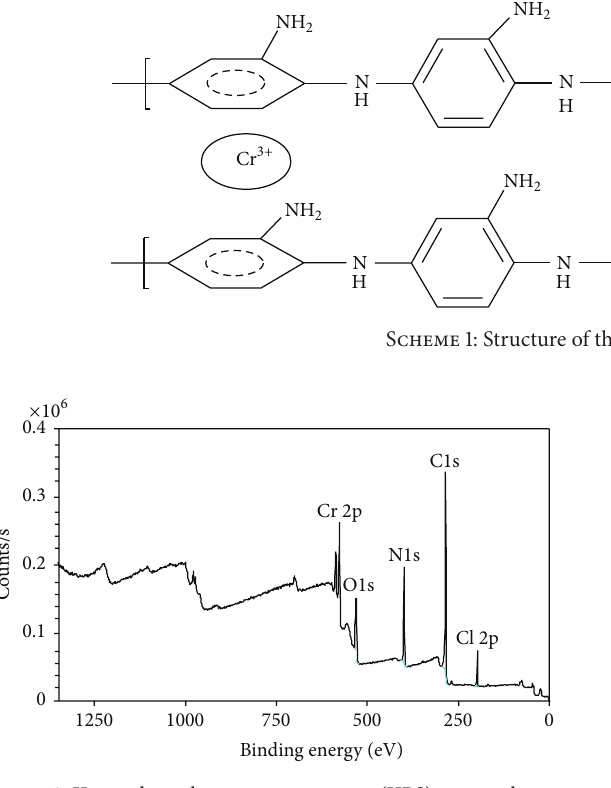
Figure 10: X-ray photoelectron spectroscopy (XPS) survey elemen- tal composition of poly-o-phenylenediamine (POPDA).